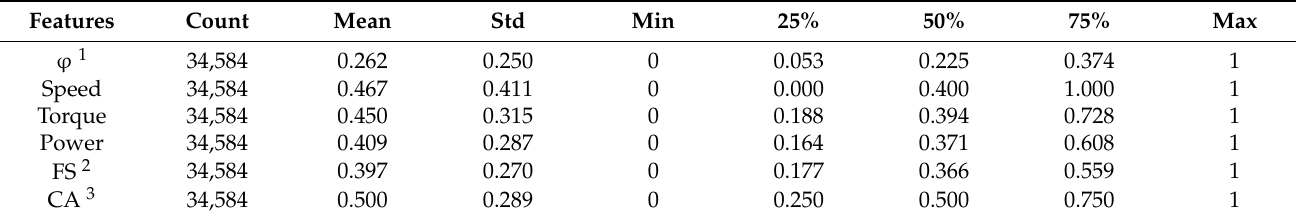
Table 5. Data description after preprocessing.